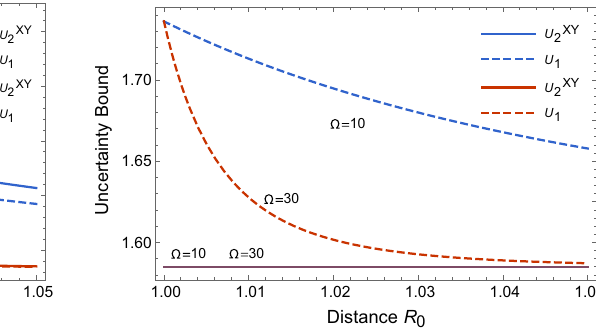
is always better than U 1 . For 2